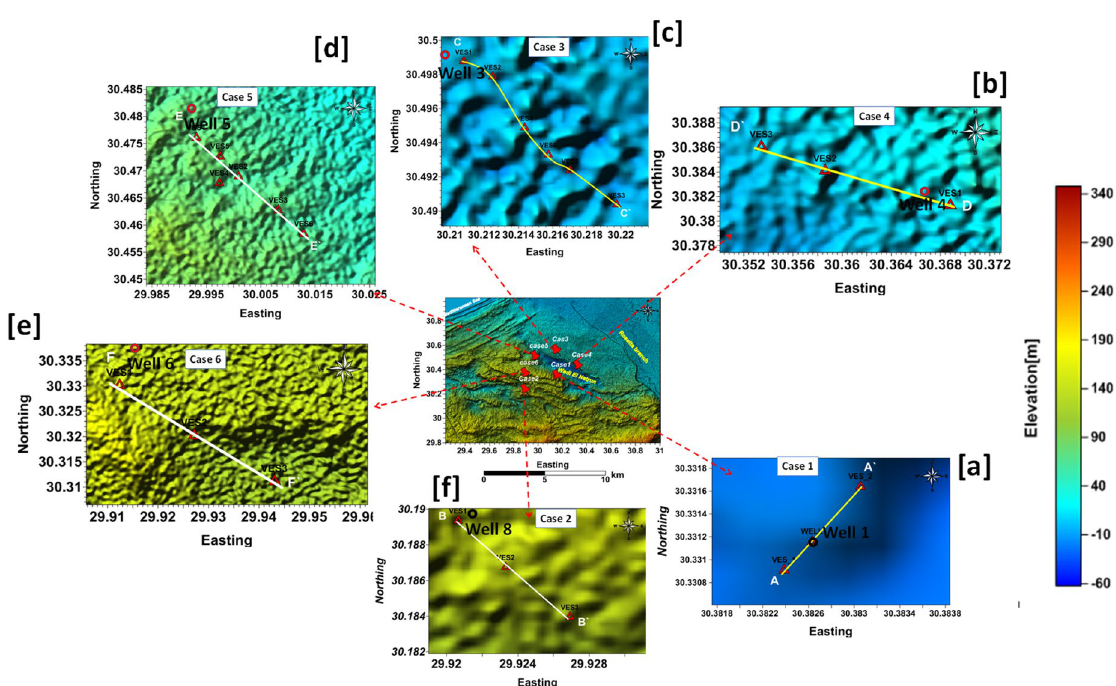
Figure 4. Location map of the case studies at wadi El Natrun and its